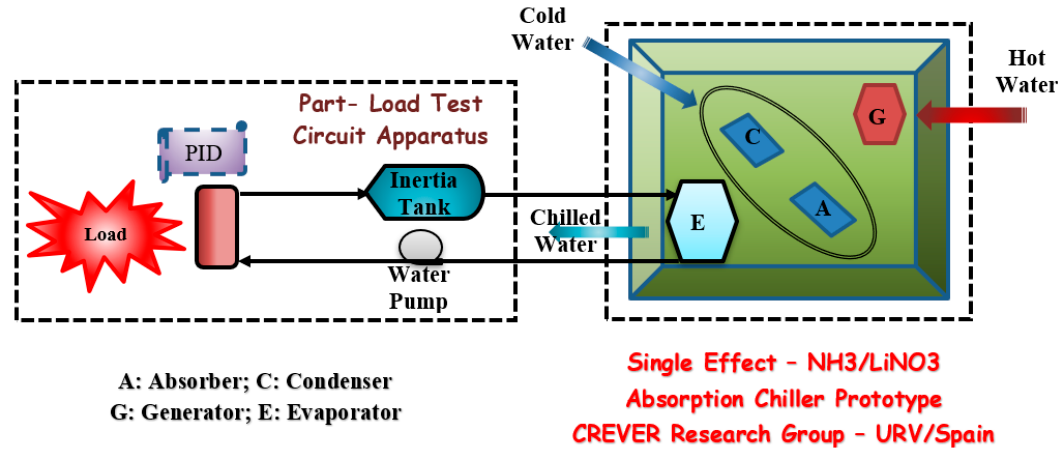
Figure 14. Schematic partial-load test circuit apparatus used to assess the absorption chiller prototypes.